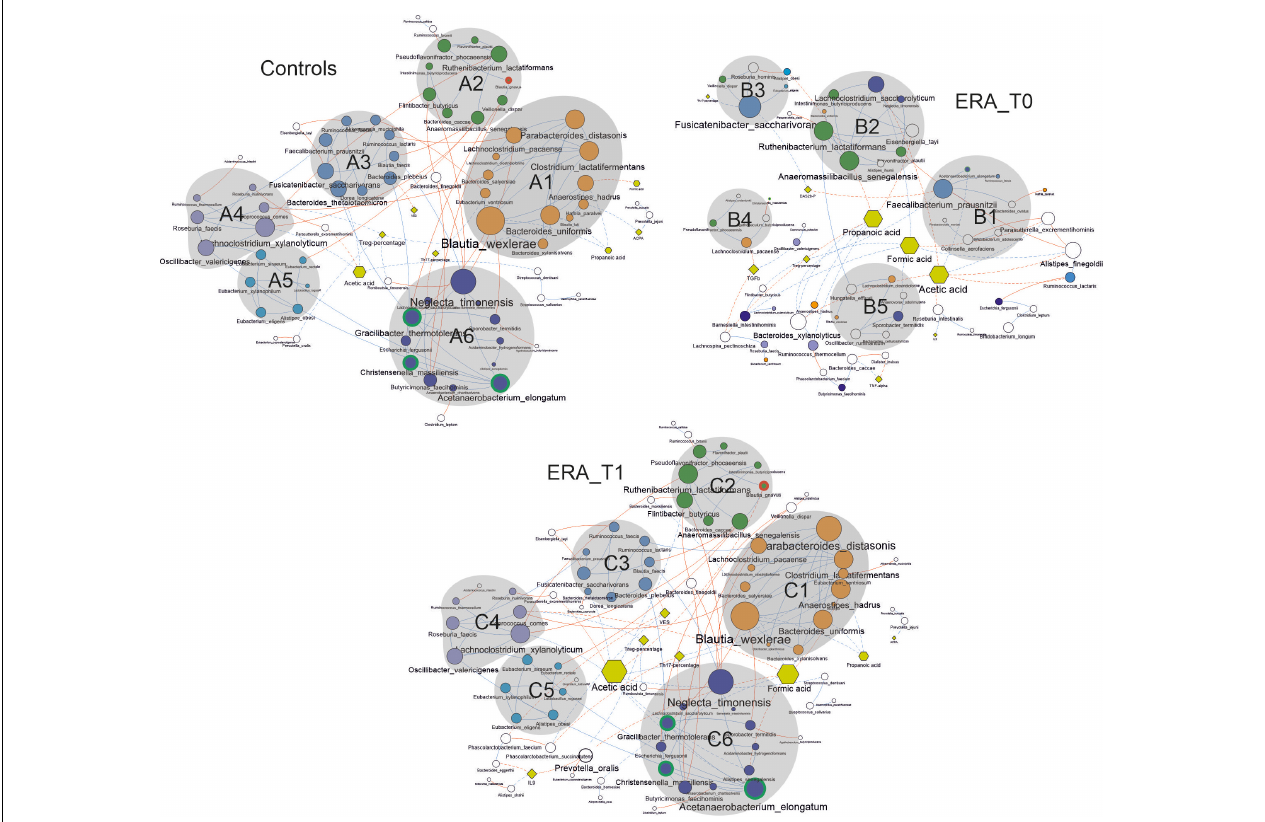
FIGURE 5 | Co-occurrence network analysis taking into account bacterial species presenting a mean relative abundance ≥ 0.01% across the whole population of samples. Node size is proportional to the number of edges departing from the node, while the edge thickness is proportional to the strength of correlations. Node name size is proportional to the betweenness centrality, meaning the bridging/key importance of that node within the network. Different shapes are used for nodes representing species (circles), clinical variables (rhombus) and metabolic variables (exagons). Continuous lines represent correlations between species while dotted ones indicate correlations between species and clinical and metabolic variables. Blue and red edges represent positive and negative correlation, respectively. Nodes are colored in agreement with the modularity class detected by the GLay algorithm in the network relative to the control